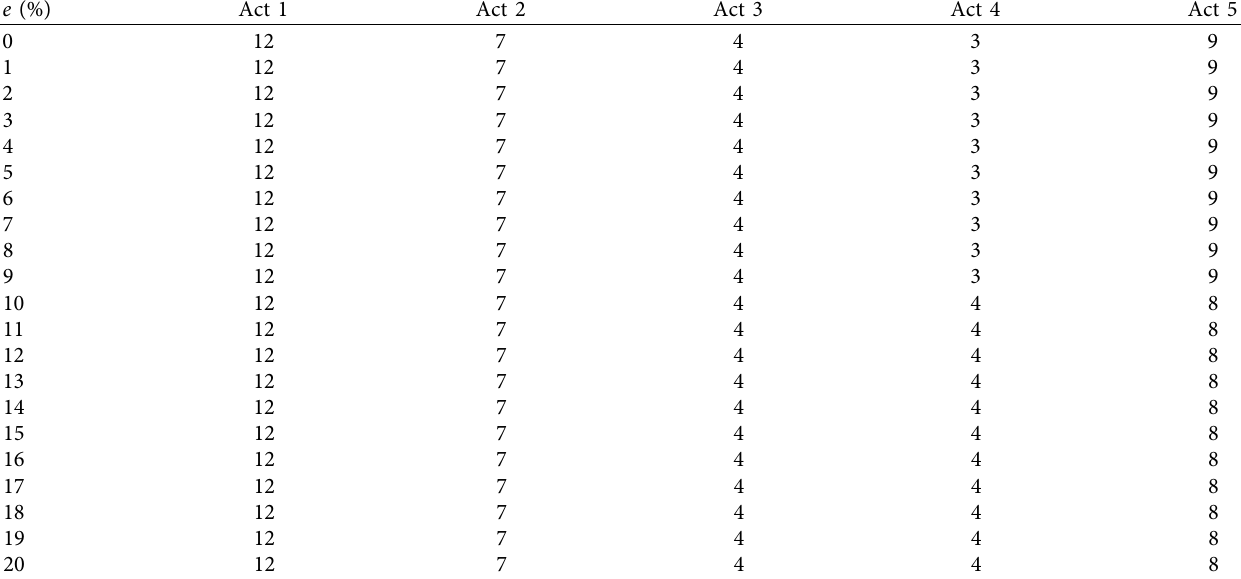
Table 5: Number of executions of each of the activities for the diferent tolerance levels.